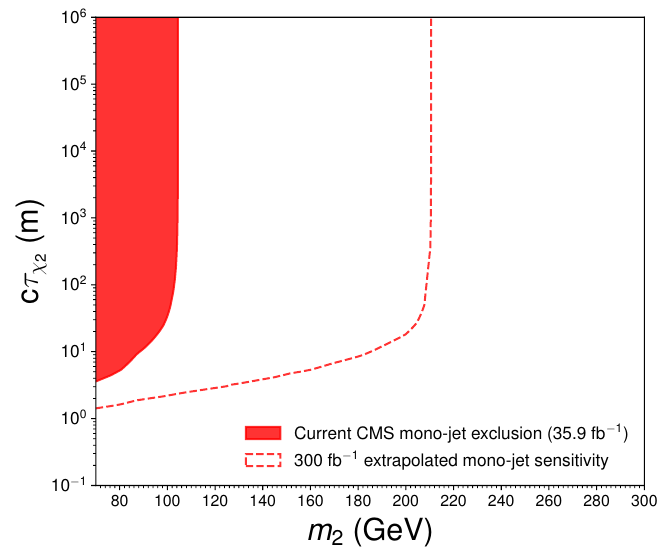
Figure 8 . Mono-jet 95% C.L. exclusion bound in the ( m 2 ; c (cid:28) naive extrapolation to 300 fb (cid:0) 1 (dashed), see text for